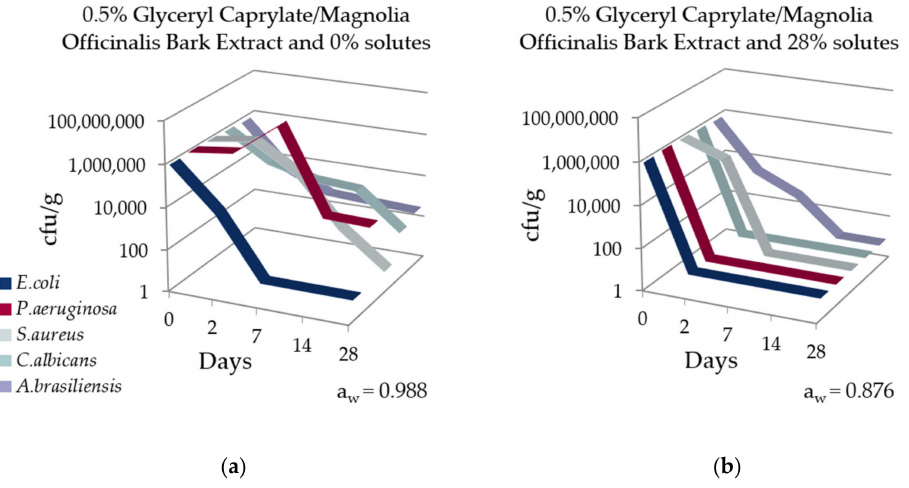
Figure 3. Challenge test results of the o/w emulsion with 0.5% Glyceryl Caprylate/Magnolia Officinalis Bark Extract ( a ) without solutes (a w = 0.988) and ( b ) with 28% solutes (a w = 0.876), indicating the colony-forming units (cfu/g) for the germs E. coli , P. aeruginosa , S. aureus , C. albicans and A. brasiliensis after 2, 7, 14 and 28